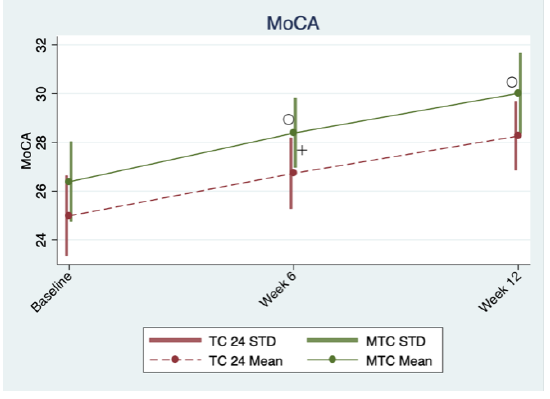
Figure 2. Interaction plots for indices of cognitive function.